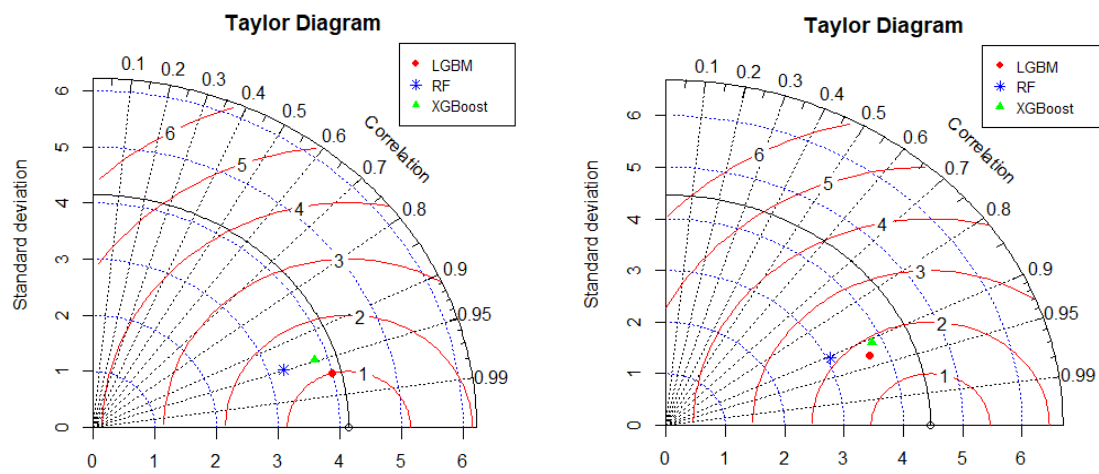
Figure 6. Comparison of the developed models using Taylor diagrams (LHS: training, RHS: testing).